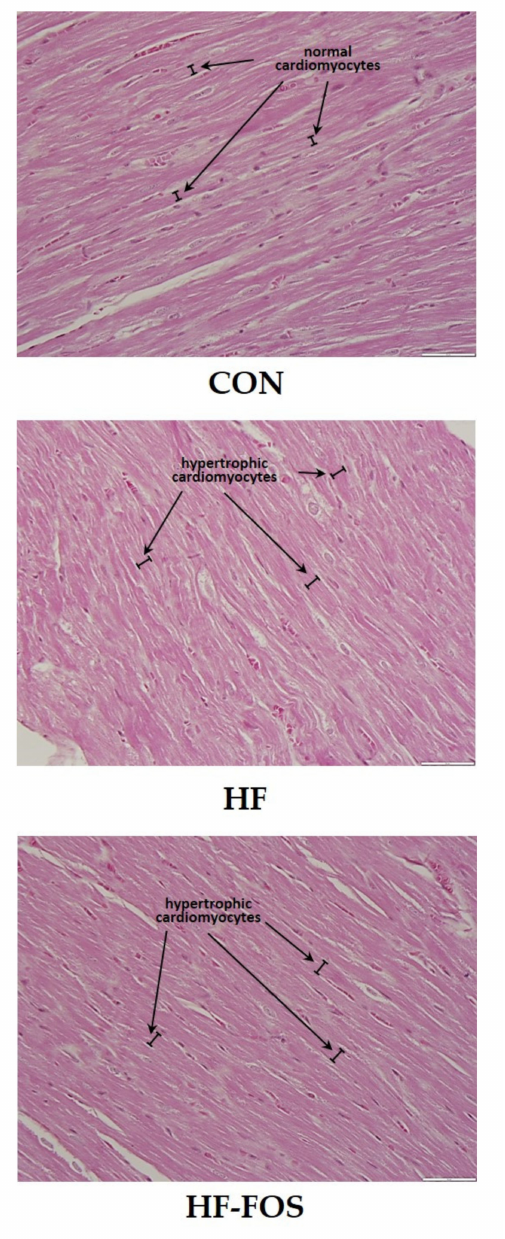
Figure 4. Sample micrographs (40 × ) of left ventricular tissue from CON, HF and HF-FOS groups with representative cardiomyocytes identified. CON, control diet; HF, high-fat diet; HF-FOS, high-fat diet supplemented with